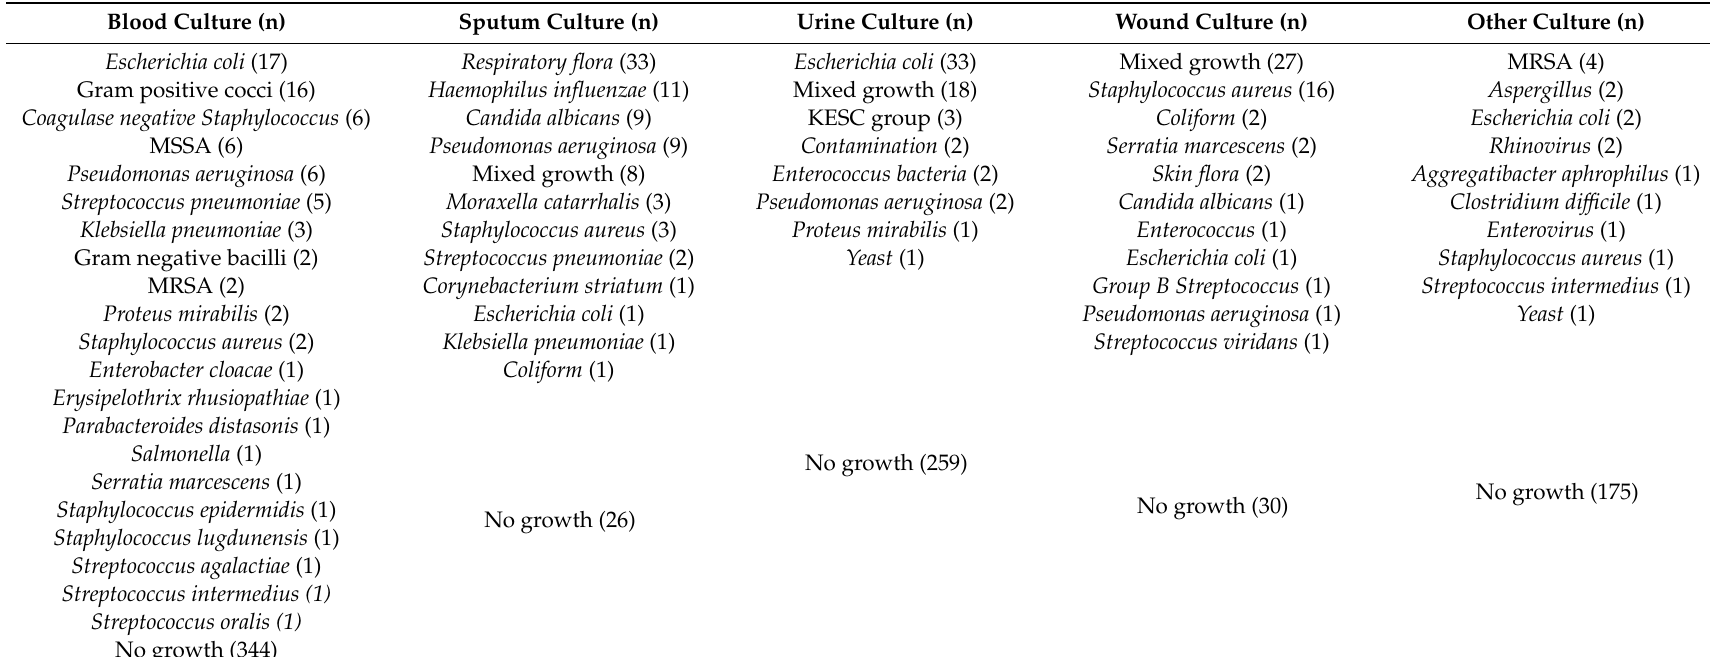
Table 2. Organisms identified by microbiological